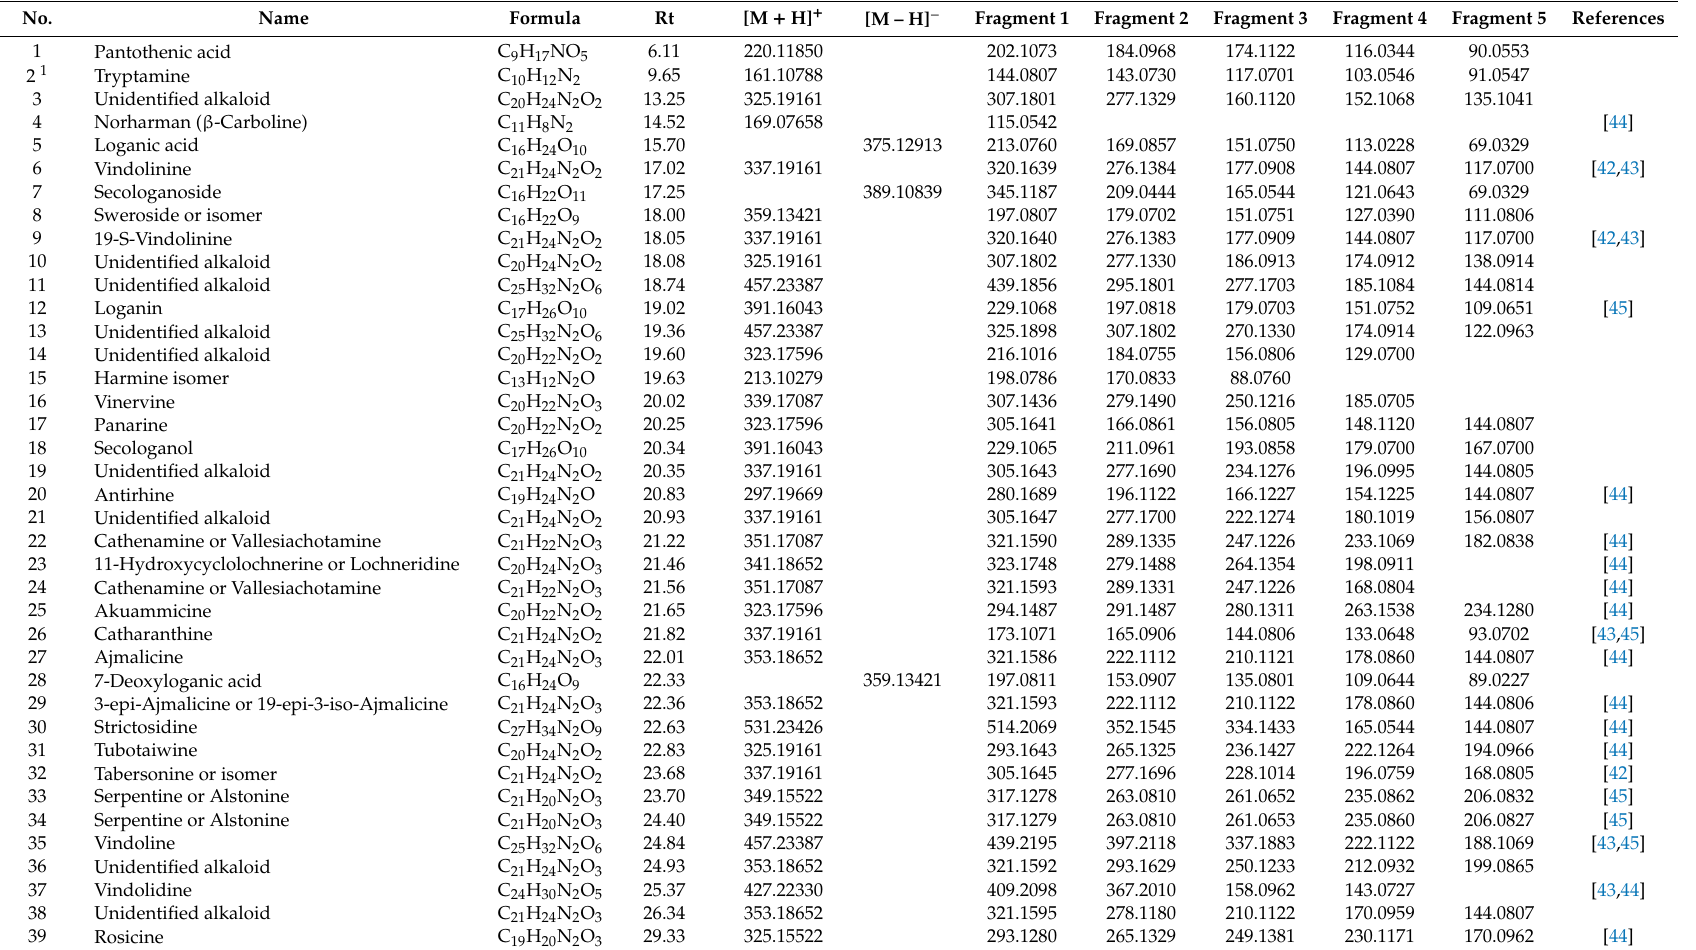
Table 10. Chemical composition of callus of Catharanthus roseus